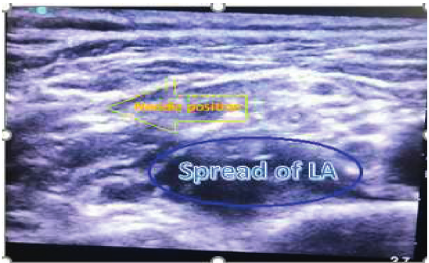
Figure 2: A spread of local anesthetic (LA) appears anechoic below the divisions of the brachial plexus with the needle in-plane from lateral to